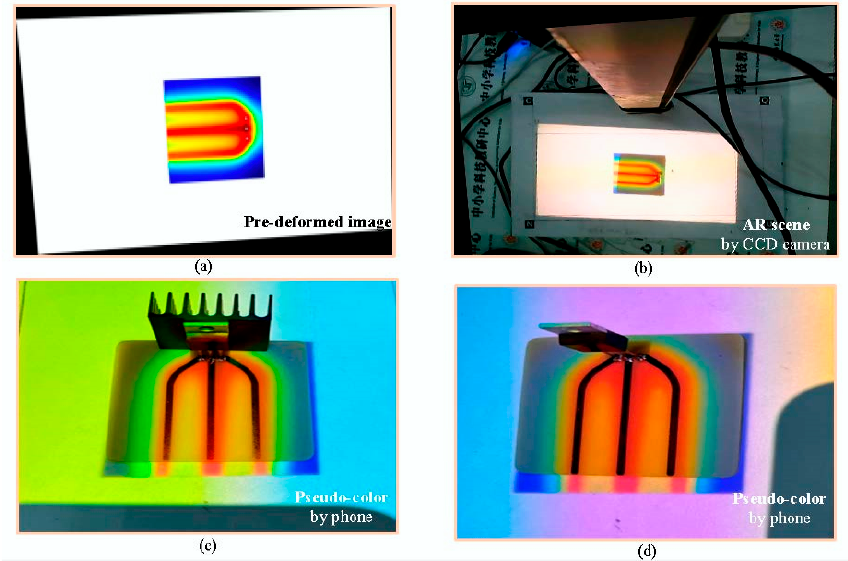
Figure 7. AR scene of the thermal management experiment of MOSFET on PCB. ( a ) Pre-deformed image of temperature distribution on PCB; ( b ) platform image captured by the CCD camera; ( c ) shot on a camera phone for the experiment configured with a sink; and without a sink ( d ).